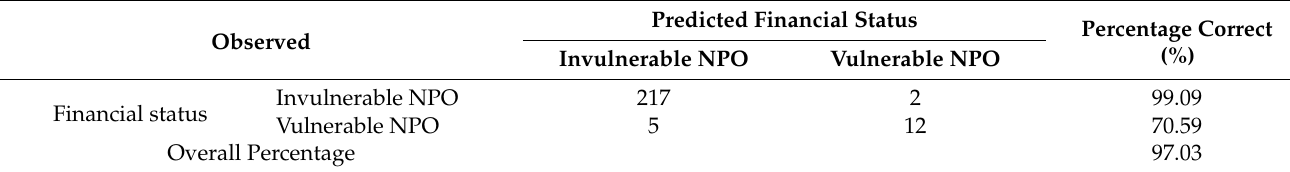
Table 9. Classification table a